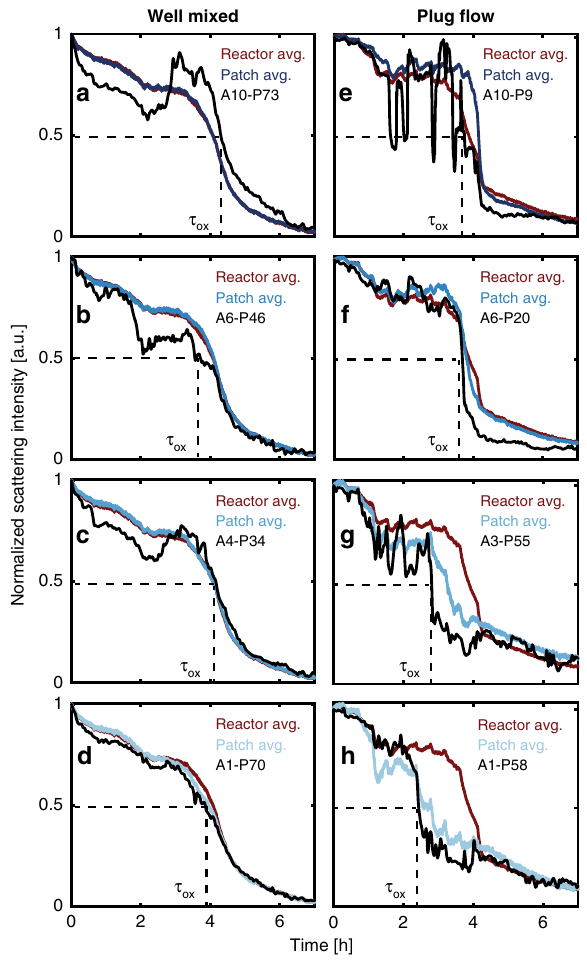
Fig. 7 Optical response of selected individual Cu particles. Four individual particle responses from the well-mixed ( a – d ) and the plug- fl ow ( e – h ) reactor. Red lines correspond to each reactor average scattering intensity, blue lines to the relevant patch average and the black lines to single particle responses. The single particle legends correspond to the patch (A) (cf. Fig. 2a, b) and particle number (P) within the